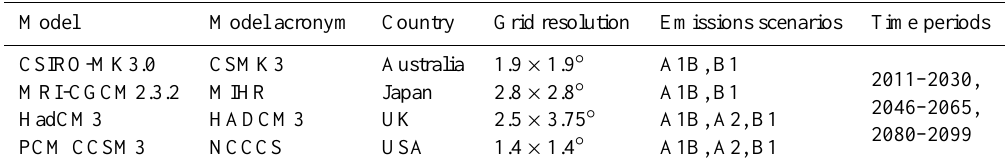
Table 1. Details of the GCMs and scenarios used in this study. The three time periods represent climate predictions in the short-term